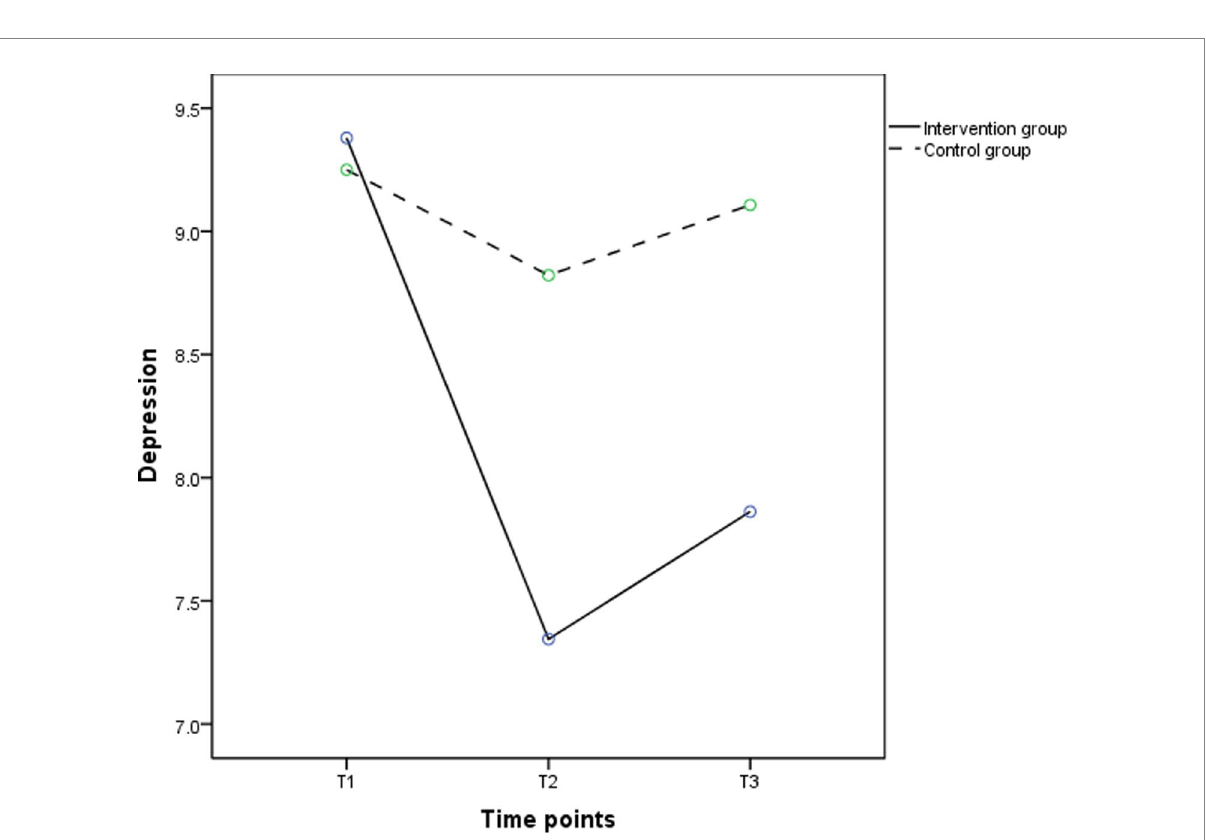
FIGURE 3 The trends in mean scores of depression in the intervention (solid line) and control groups (dashed line) between baseline and 3 months post intervention.